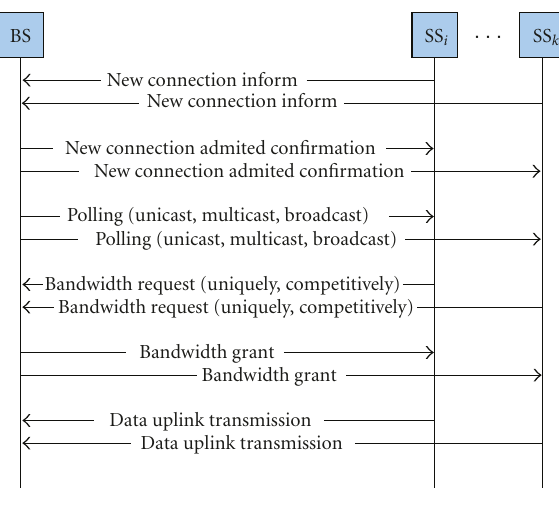
Figure 3: Polling-request-grant